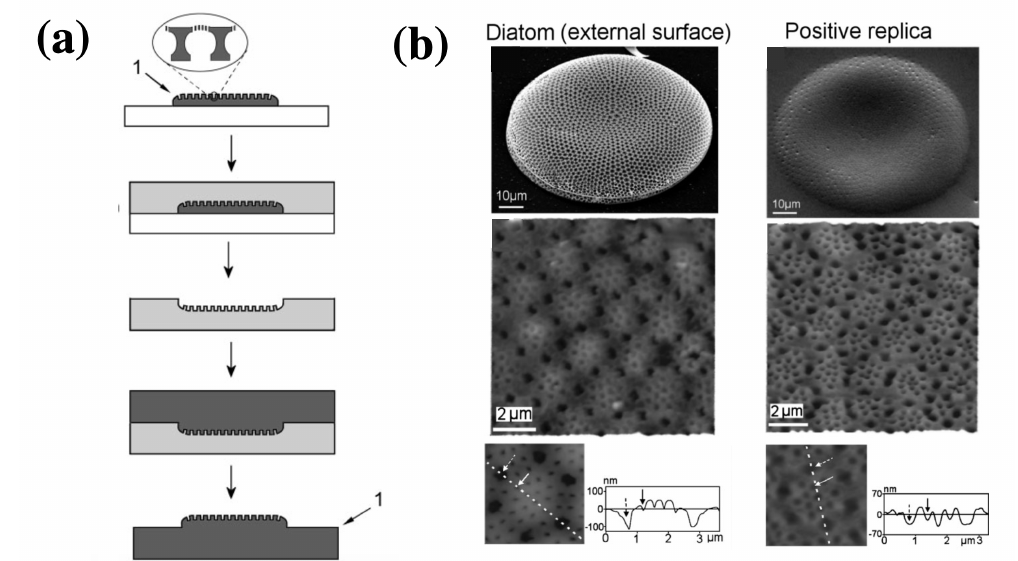
Figure 9. ( a ) Schematic representation of the replica molding process described in Ref. [101]: a single valve is transferred into a PDMS matrix (negative replica) which in turn is replicated into mercaptol ester type UV curable polymer (NOA60), thus leading to a positive replica. ( b ): SEM and AFM images of a single Coscinodiscus sp. valve (left column) and NOA 60 replica of its cribrum (right column). Adapted with